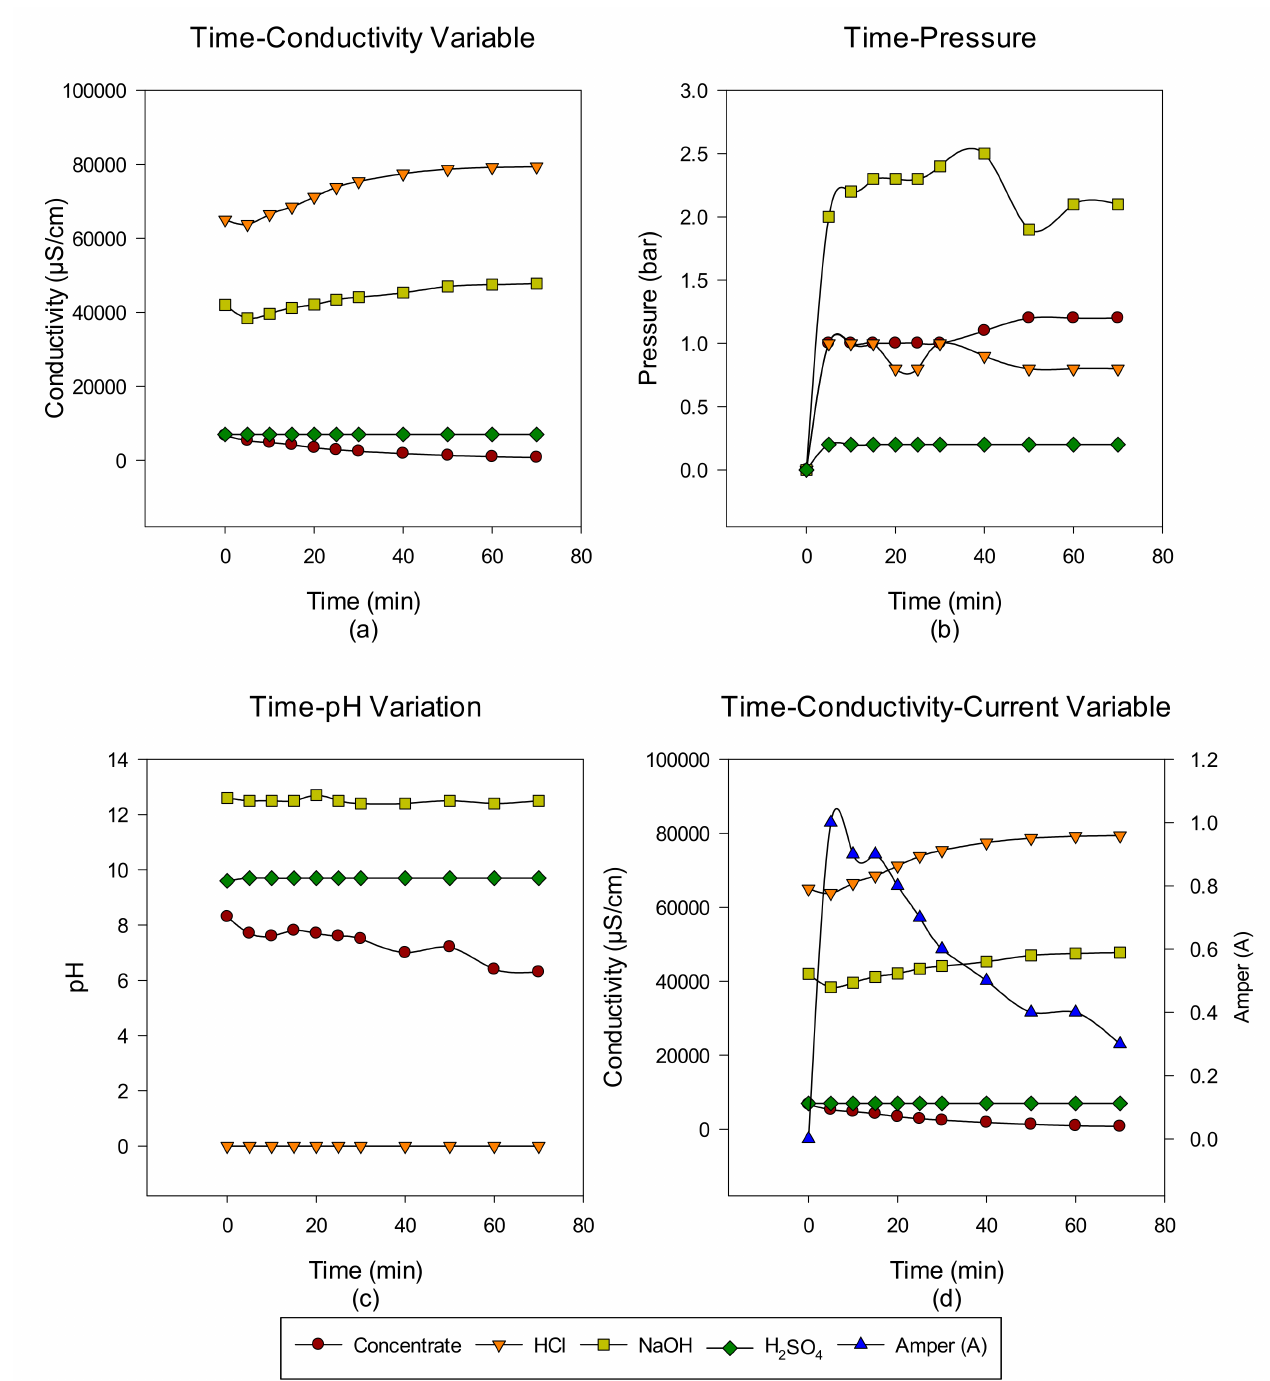
Figure 7. NaCl–NaOH–HCl–Na 2 SO 4 ( a ) conductivity, ( b ) pressure, ( c ) pH, and ( d ) conductivity and ampere change between 0 and 70